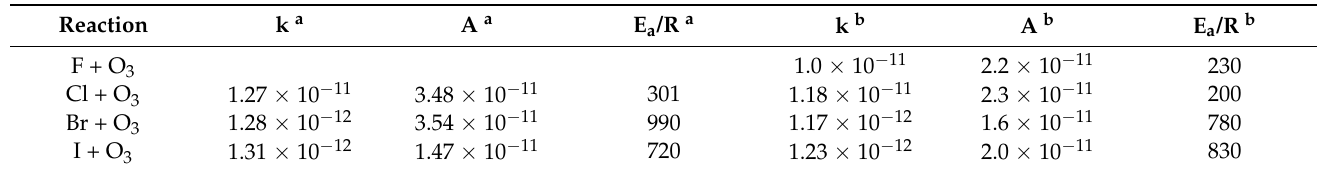
Table 11. Rate coefficients at 298 K (cm 3 molecule − 1 s − 1 ), pre-exponential factors (cm 3 molecule − 1 s − 1 ), and activation energies/R (K) for the reactions of O 3 with F, Cl, Br, and I atoms.